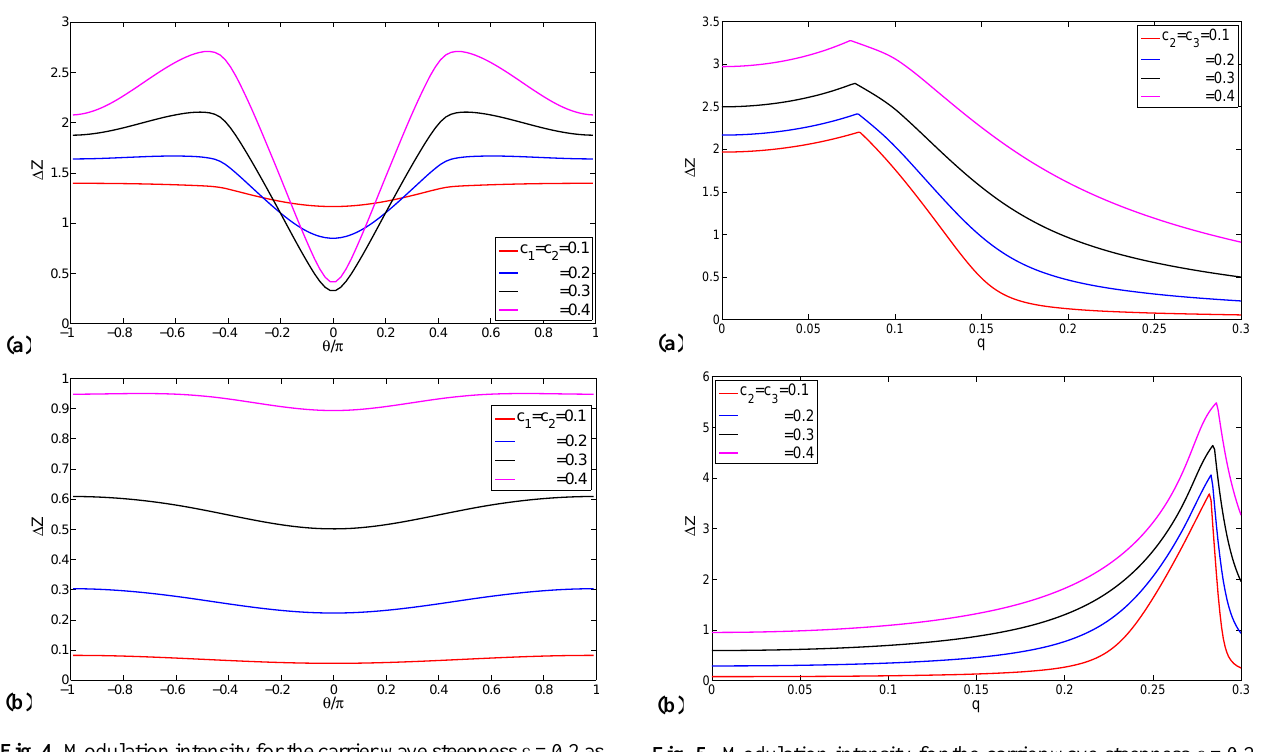
Fig. 5. Modulation intensity for the carrier wave steepness ε =0.2 and the initial phase angle θ = 0 . 7 π as a function of q for: (a) p =0.2; (b) p = 0 .